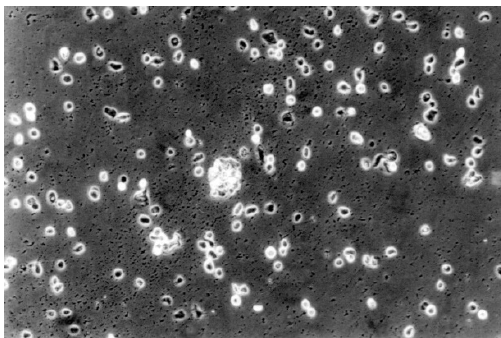
Figure 11. All fibroblasts under the influence of Optibond Solo Plus (No. 6) are in the process of dying. Many rounded and dead fibroblasts found already in the cell culture (100-fold magnification).